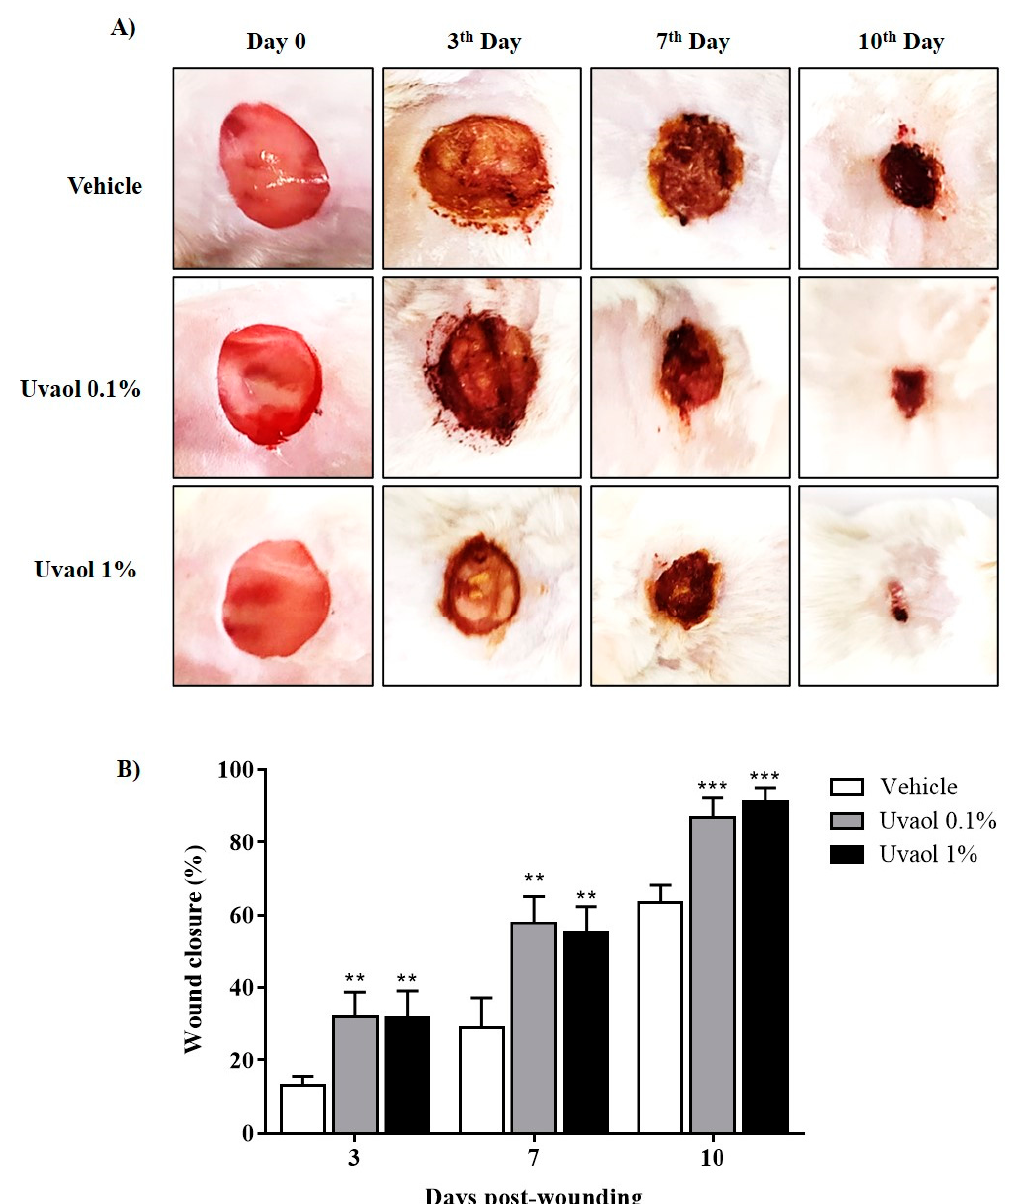
Figure 8. Effect of the topical application of uvaol in the excisional wounds of mice. ( A ) Representative photographs of wounds on days post wounding of animals treated with vehicle (PBS) and uvaol (0.1% or 1%). ( B ) Wound closure kinetics. The bars represent mean ± SD, n = 5 for each time point and group. Statistical differences were detected with two-way ANOVA followed by the Bonferroni test. (**) p < 0.01 and (***) p < 0.001 compared to vehicle-treated cells on each respective day.